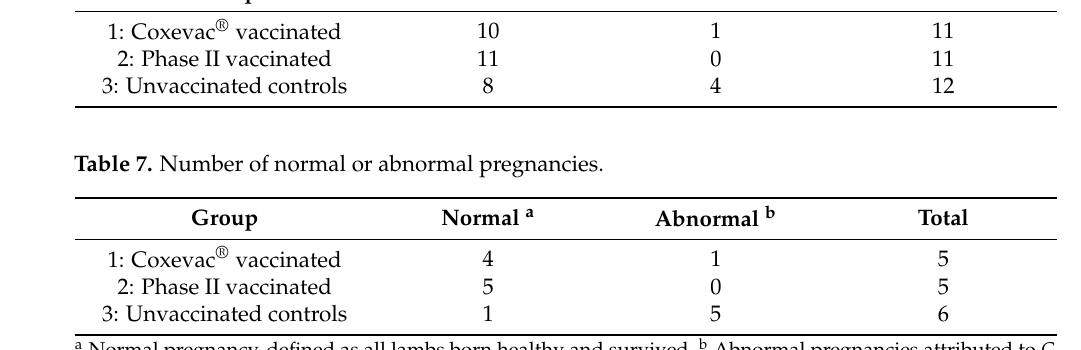
Table 6. Number of lambs that either survived or died following parturition. Group